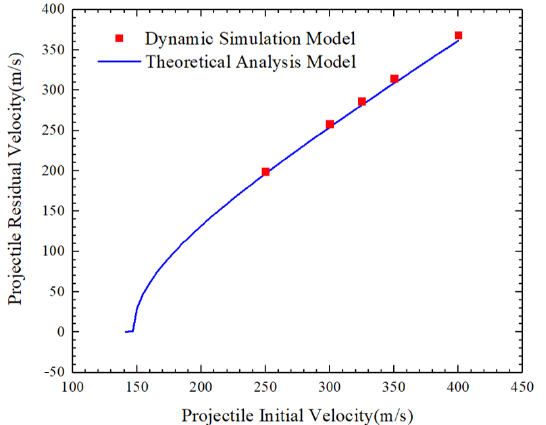
Figure 8. Comparison of the initial and residual velocity between the theory and simulation.